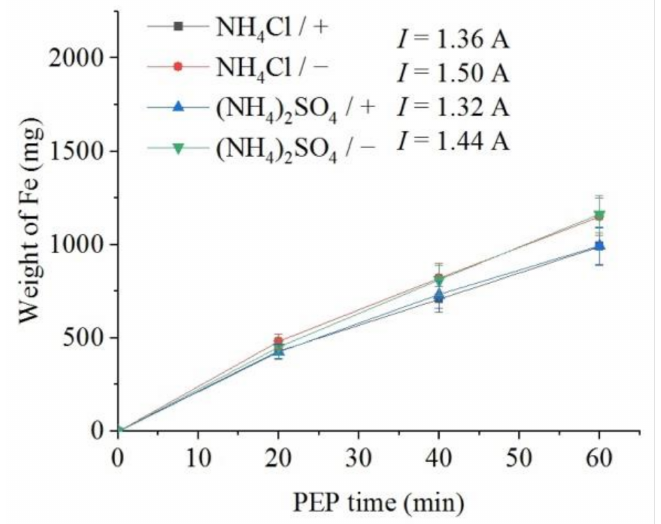
Figure 7. Dependence of iron weight dissolved from the nitrided samples on the PEP duration at 300 V in ammonium sulfate (3%) or ammonium chloride (3%) solutions at their temperature of 80 ◦ C under forced circulation (+) or natural convection ( − ) of